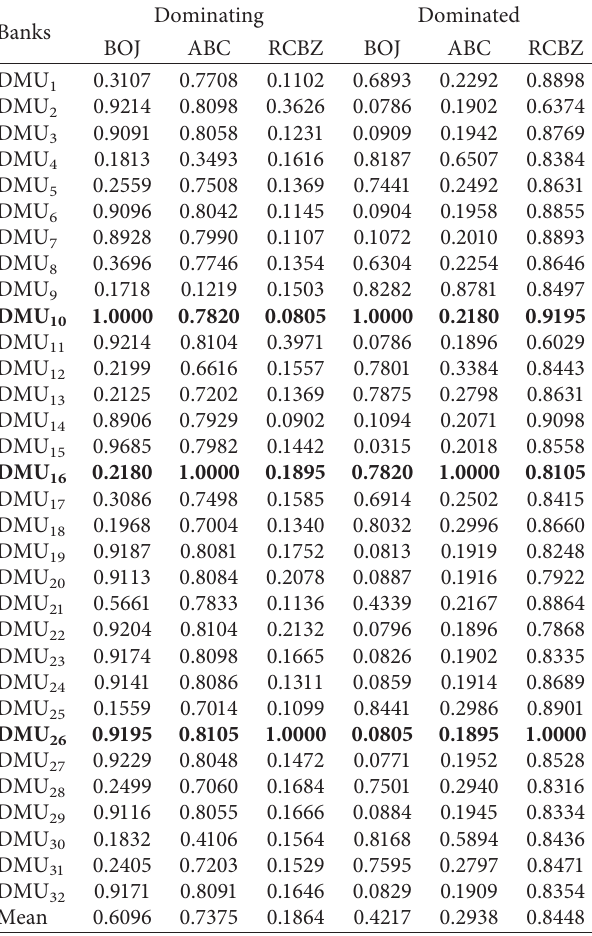
Table 6: Pairwise dominance probability for BOJ, ABC, and RCBZ in 2018.